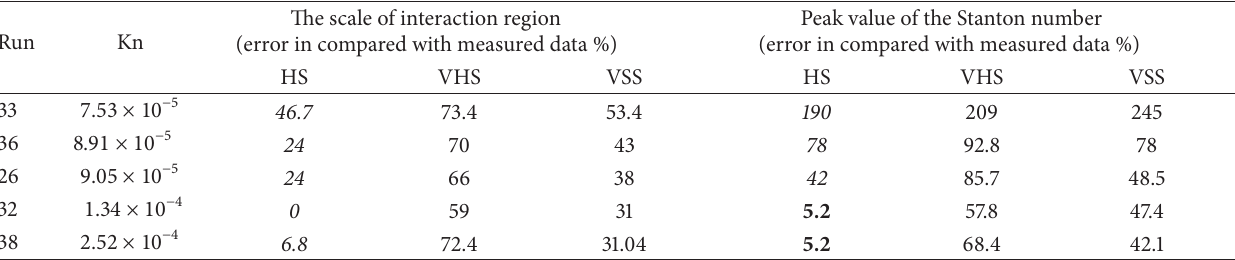
− Value )/( Value )) . DSMC experiment experiment Peak value of the Stanton number (error in compared with measured data %)